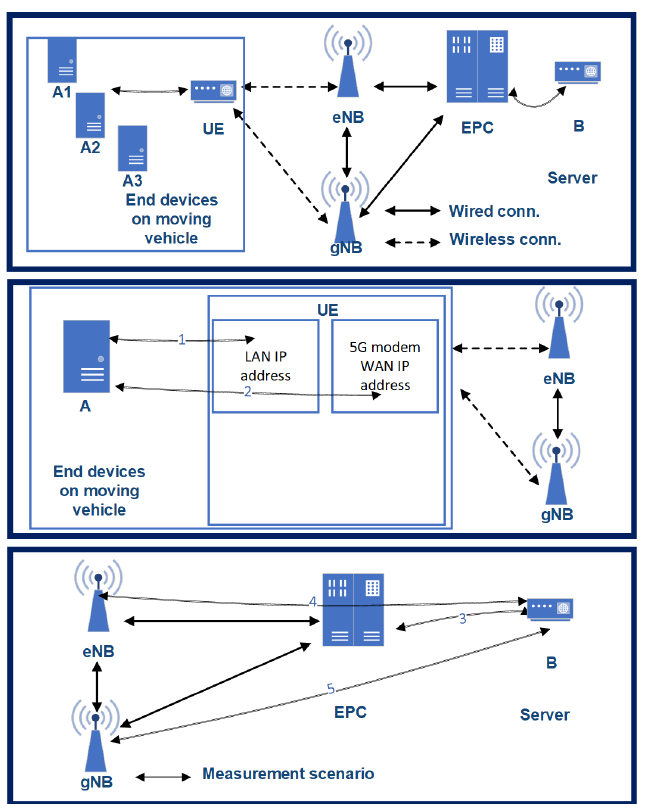
Figure 21. The architecture of the 5G testbed—as 3GPP Option